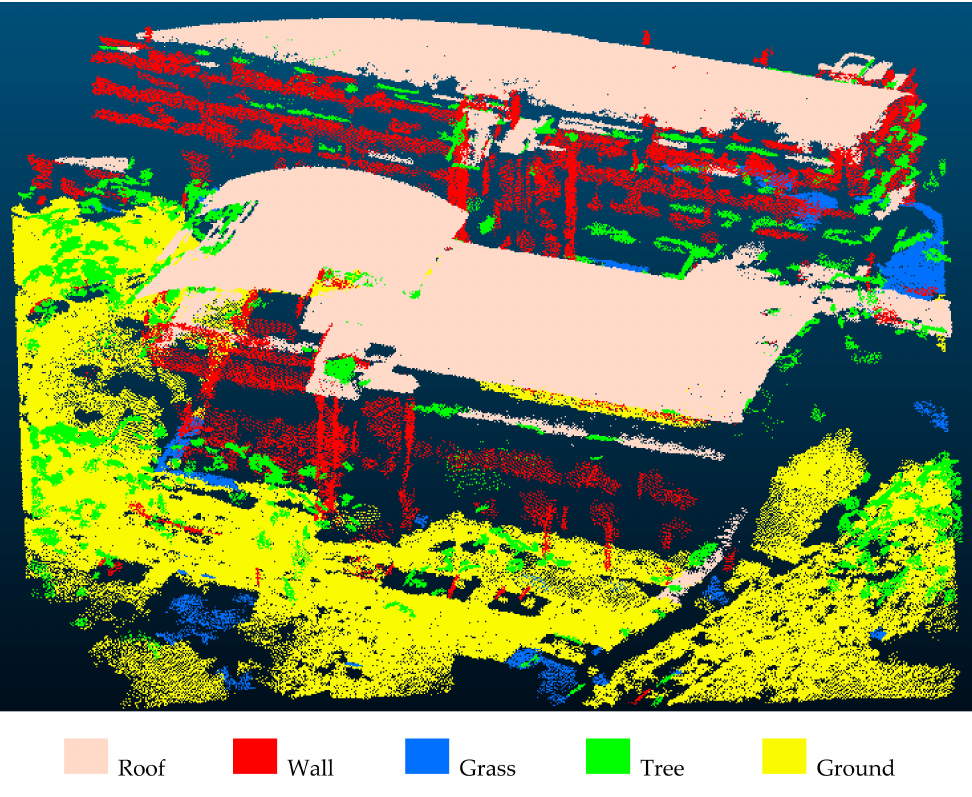
Figure 9. Classification results of the point cloud in Dataset1. Table 2. Quantitative classification results of point clouds in